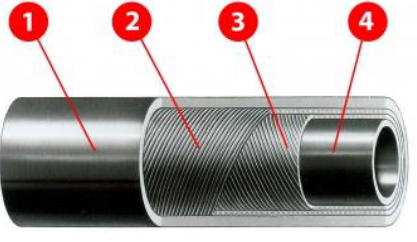
Fig. 6. Flexible fuel gas hose